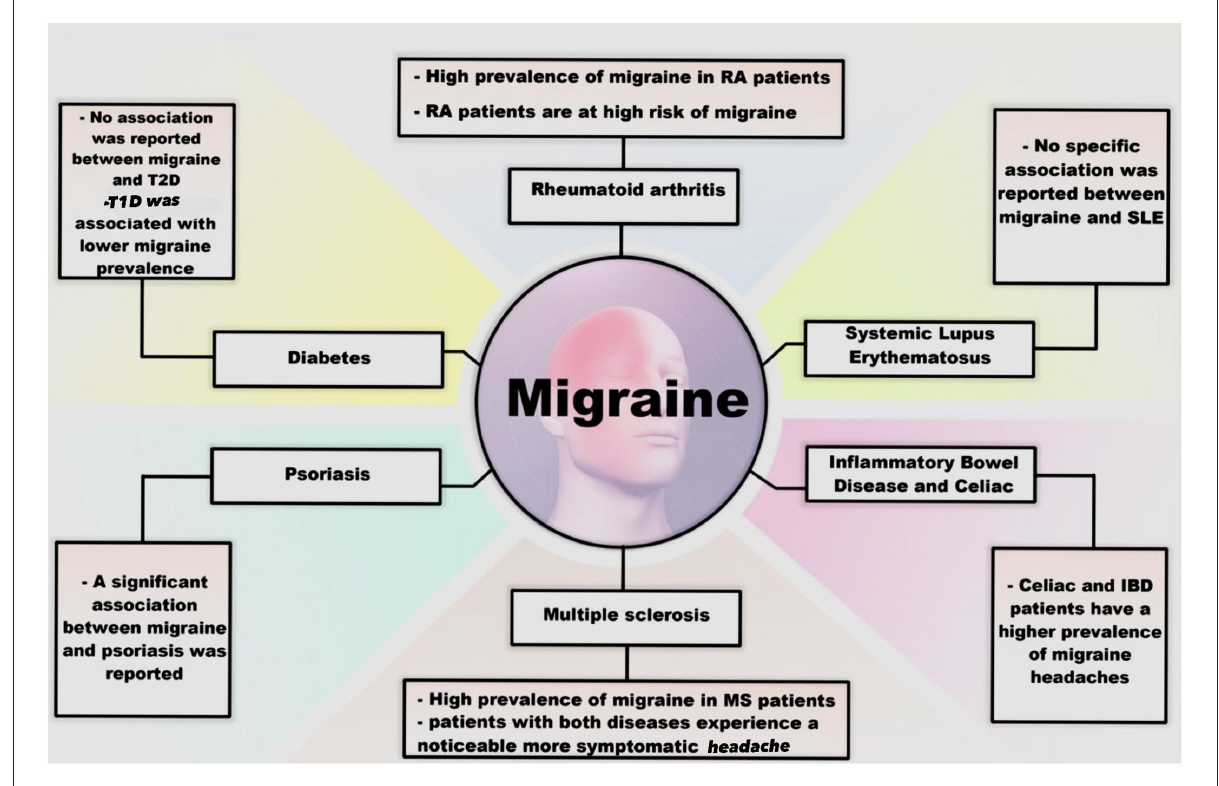
FIGURE2 The association between migraine and autoimmune